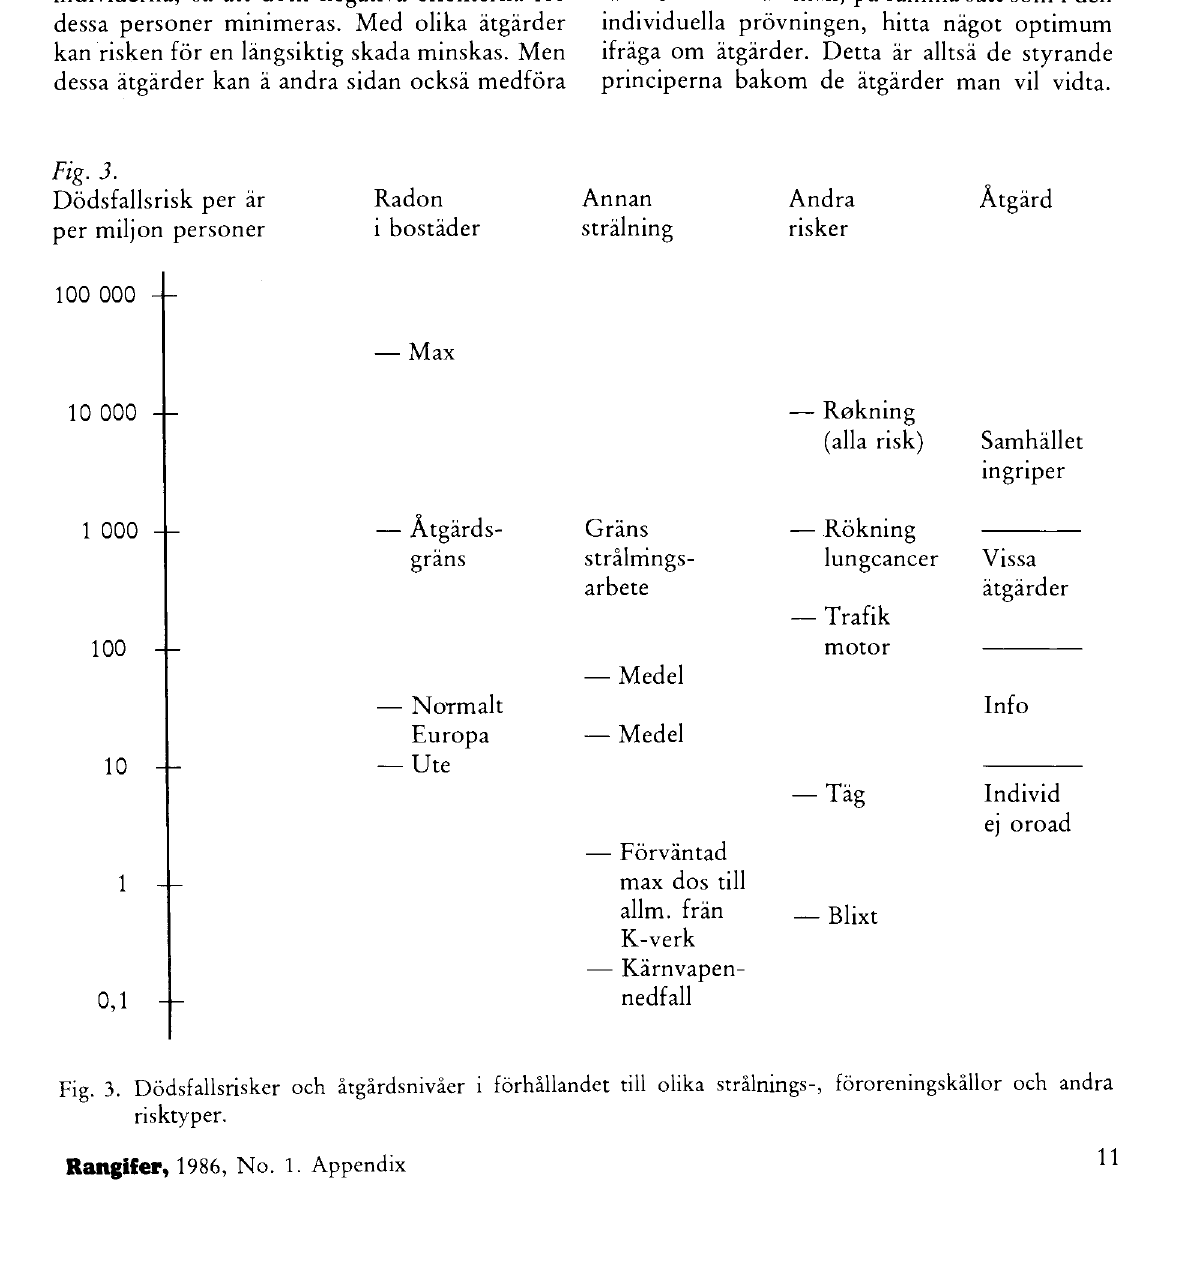
Fig. 3. Dodsfallsrisker och åtgårdsnivåer i forhållandet till olika strålnings-, fororeningskållor och andra